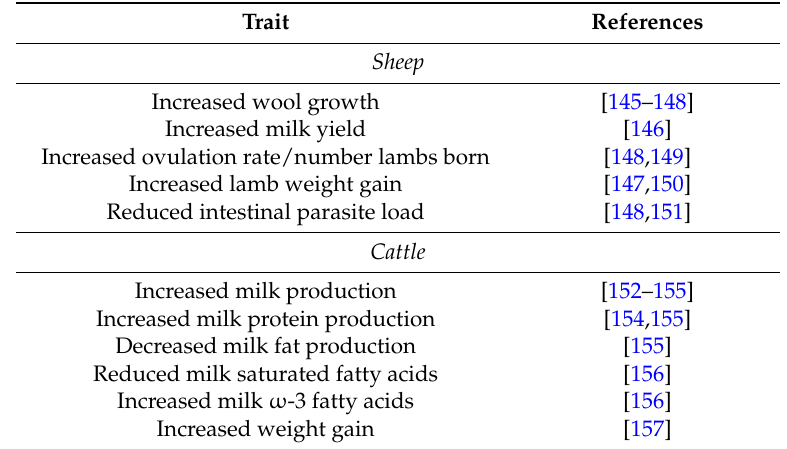
Table 4. Effect of feeding birdsfoot trefoil and big trefoil with proanthocyanidin concentrations between 2% and 5% on performance of sheep and